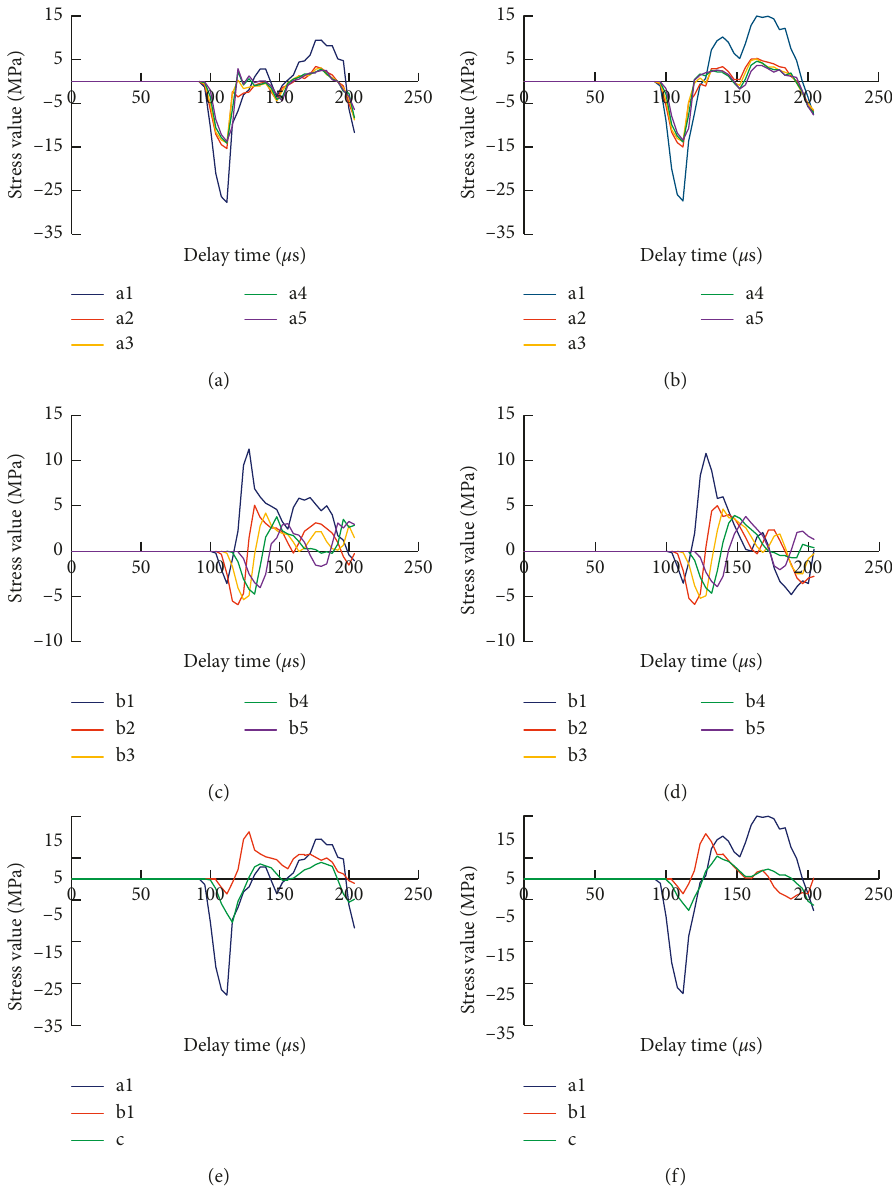
Figure 11: Elements of the TBH wall stress concentrate curve before TBH initiation when the delay time is 194 μ s. (a, c, e) The PBH is a round hole. (b, d, f) The PBH is a notch